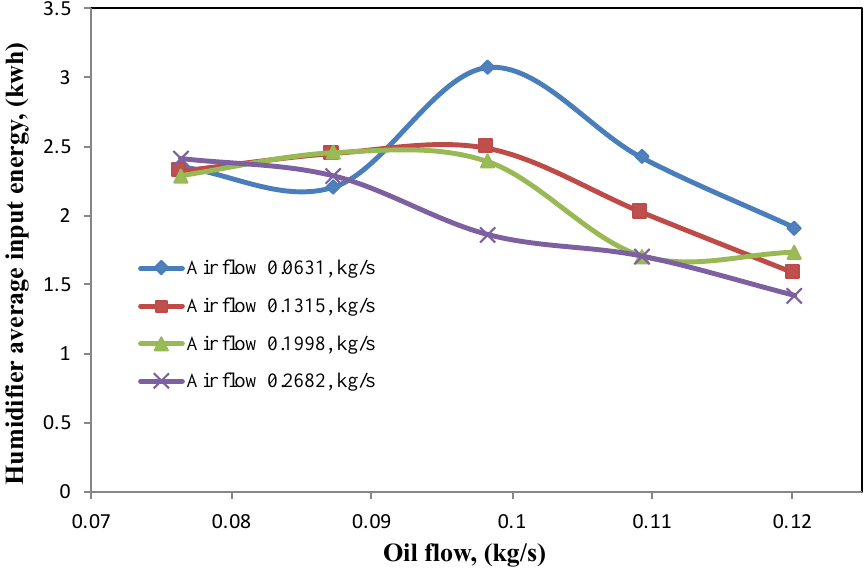
Figure 12. HD average input energy at different air and oil flow rates.